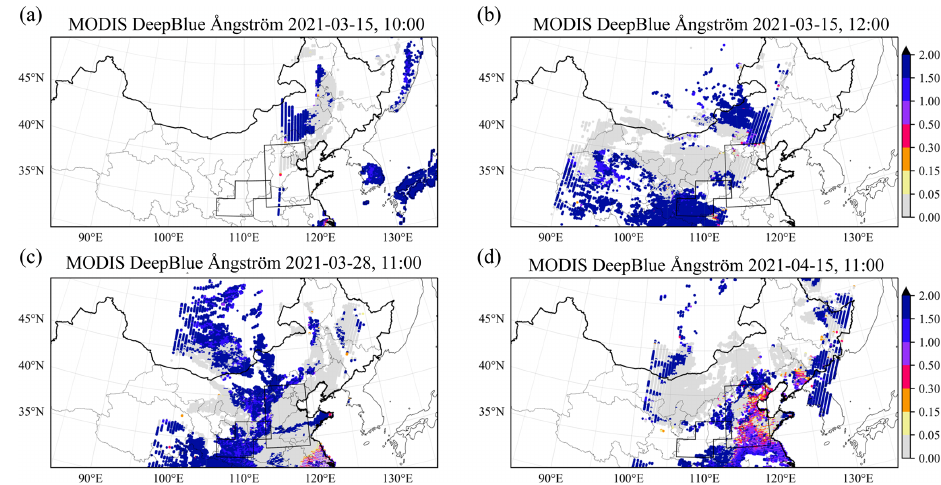
Figure 5. Snapshots of MODIS Deep Blue Ångström exponent accompanying AOD scenes shown in Figs. 2a.i–b.i, 3a.i, and